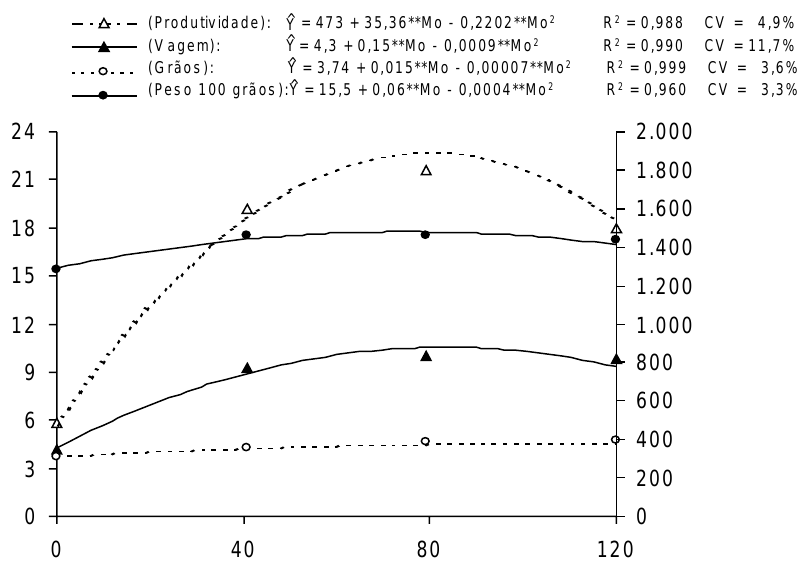
Figura 4. Produtividade de grãos, número de vagens por planta, número de grãos por vagem e peso de 100 grãos do feijoeiro cv. Ouro Negro, considerando a adubação foliar com molibdênio. ** significativo a 1% pelo teste